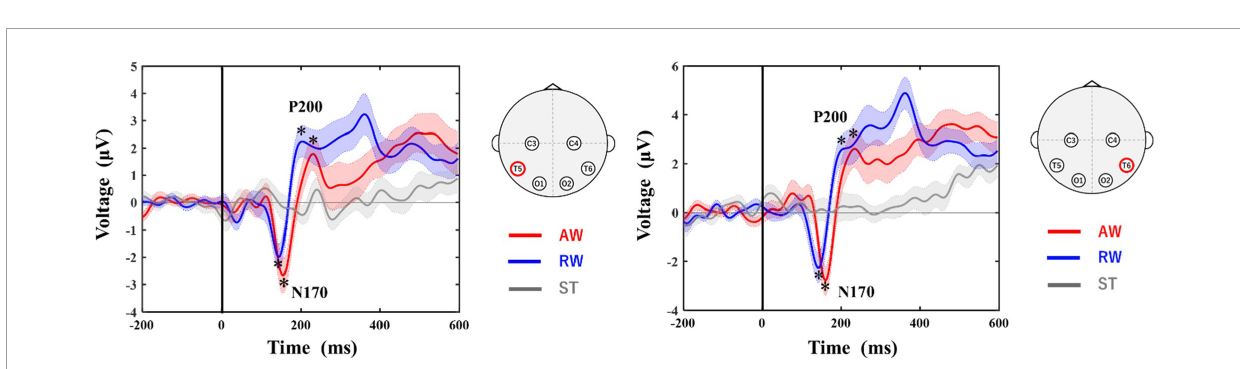
FIGURE3 Grand-averaged ERP waveforms at T5 and T6 electrodes. The horizontal axis shows the latency from the onset. The vertical line at time 0 indicates the time point when the walker started to approach/recede. The vertical axis shows the ERP potential. The red line represents ERPs in the AW condition, the blue line represents ERPs in the RW condition, and the gray line represents ERPs in the ST condition. The asterisks in the figure indicate the peak of each ERP (N170, P200) identified in this study. The shaded area around each ERP trace indicates the standard error (SE) of the mean. AW, approaching walking movement; RW, receding walking movement; ST, standing; ERP, event-related potential. *Indicates the selected peak of each ERP (N170,